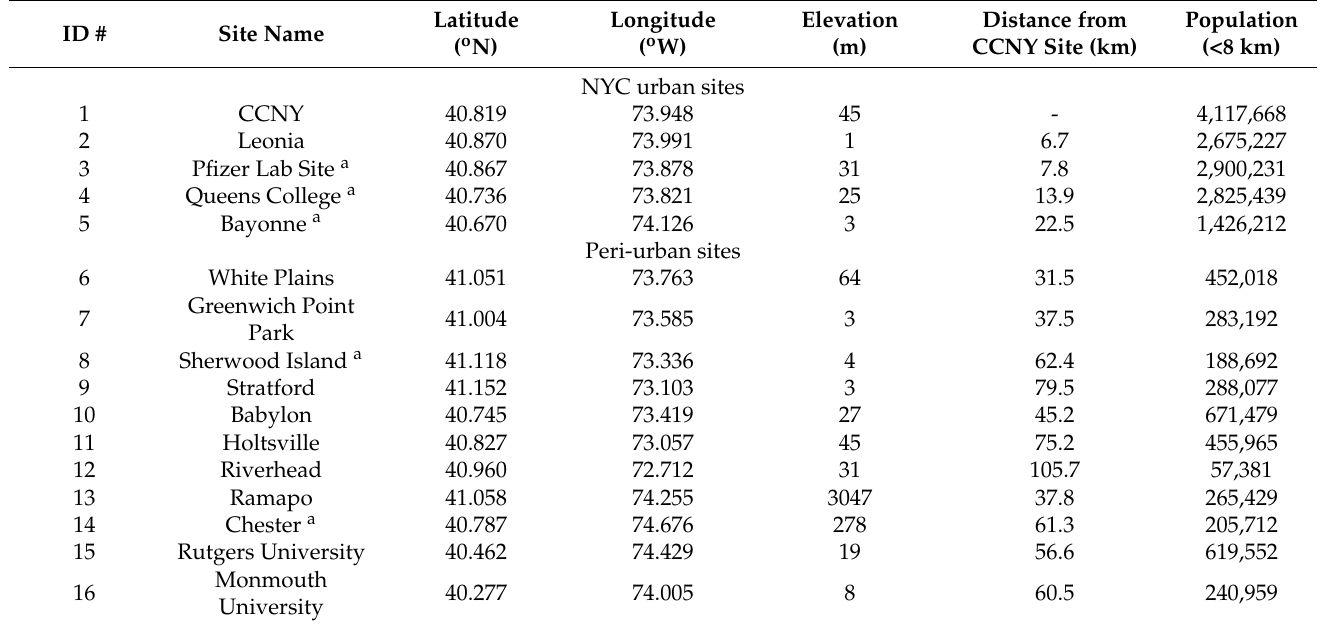
Table 1. The characteristics (ID #, name, type, latitude, longitude, elevation, distance to CCNY site, and population within an 8-miles radius of O 3 monitoring sites in the study area.